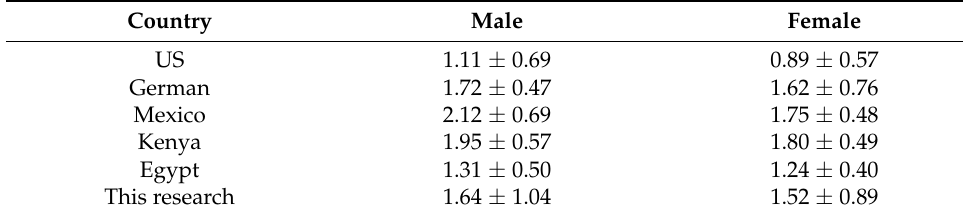
Table 7. Diet boron intake in different countries (mg B/d). Country